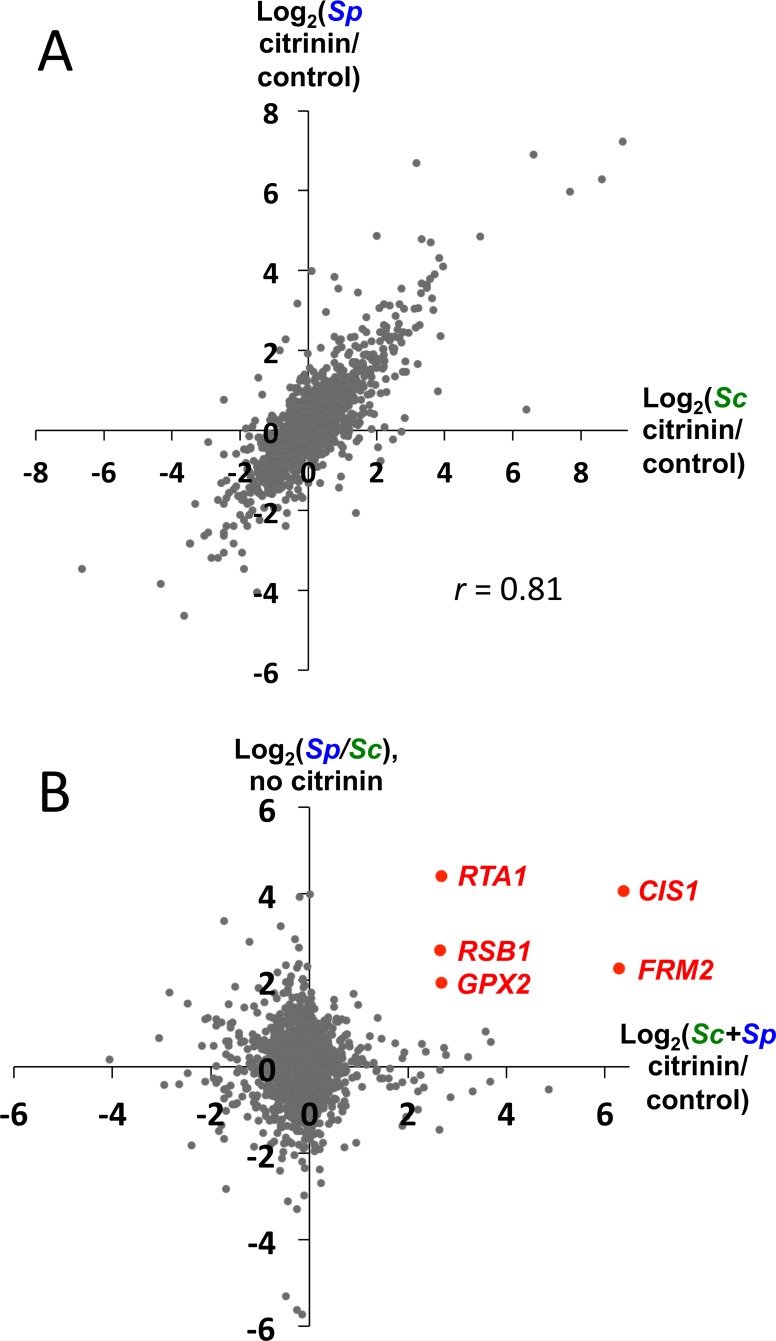
RNA-seq reveals candidate genes.
A. Citrinin has largely similar effects on Sc alleles and Sp alleles in the Sc/Sp hybrid; i.e. ASE is similar with or without citrinin. B. Candidate genes were identified based on having strong Sp-biased ASE (in YPD; FDR < 0.05) [16], and strong up-regulation in response to citrinin (of both Sc and Sp alleles; the smaller of these two in our RNA-seq data is plotted; binomial p < 10−5 for each biological replicate of each allele).